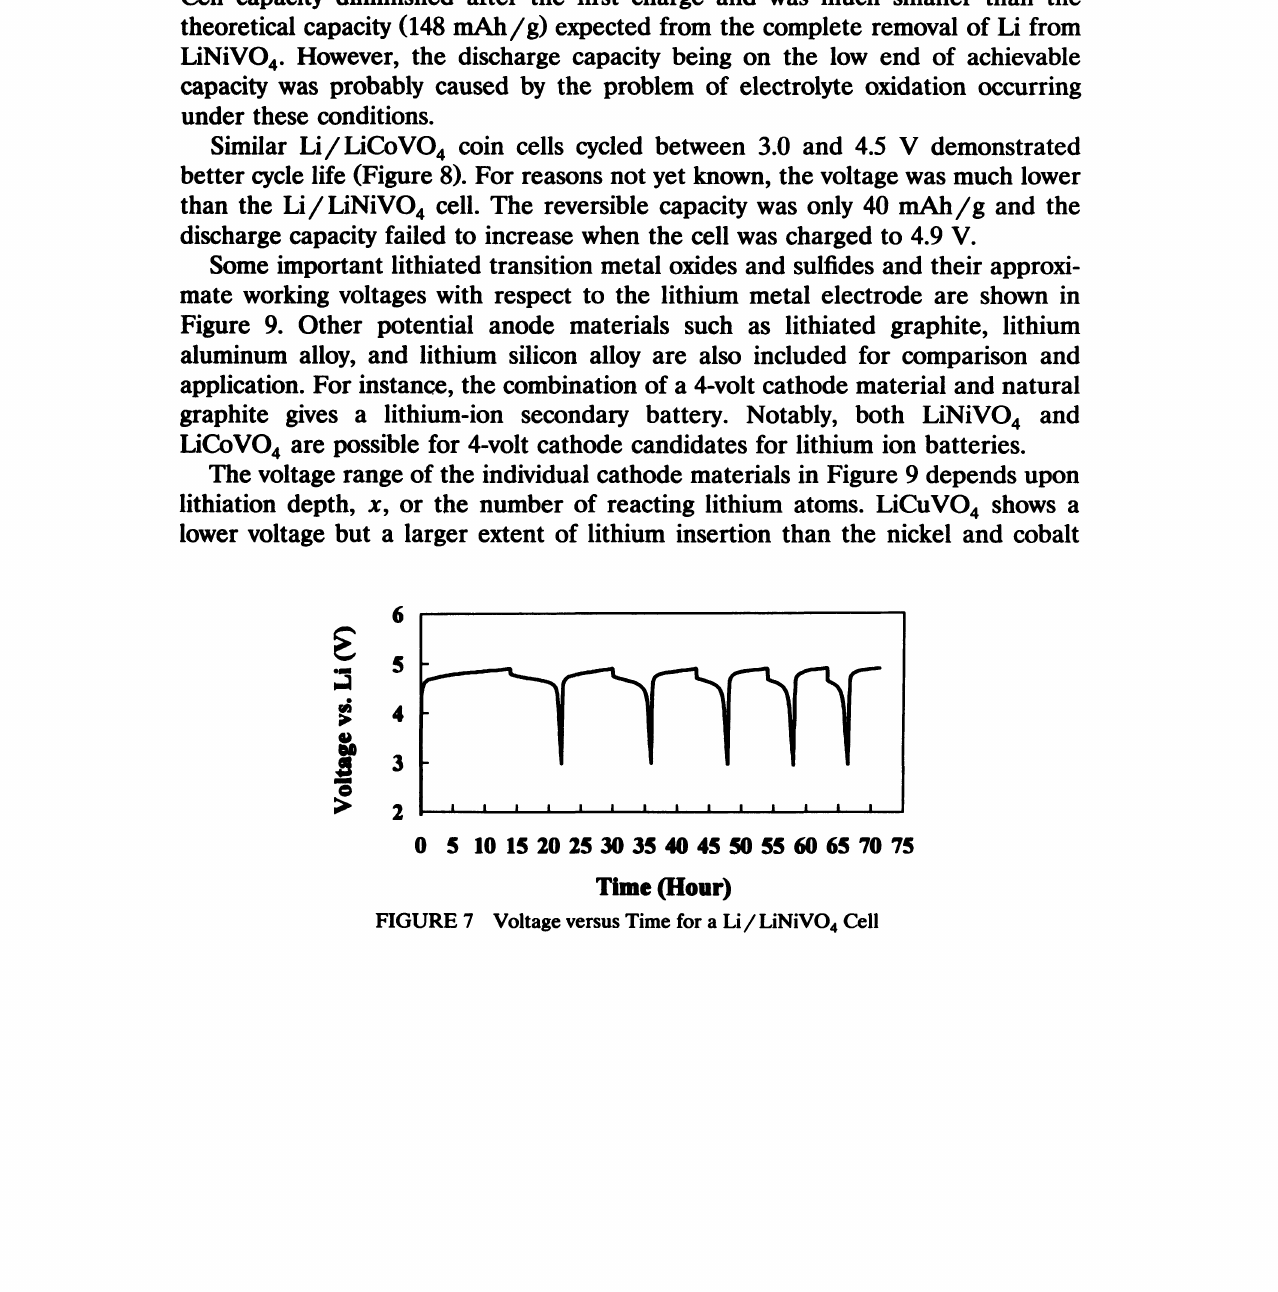
Time (Hour) FIGURE 7 Voltage versus Time for a Li/LiNiVO